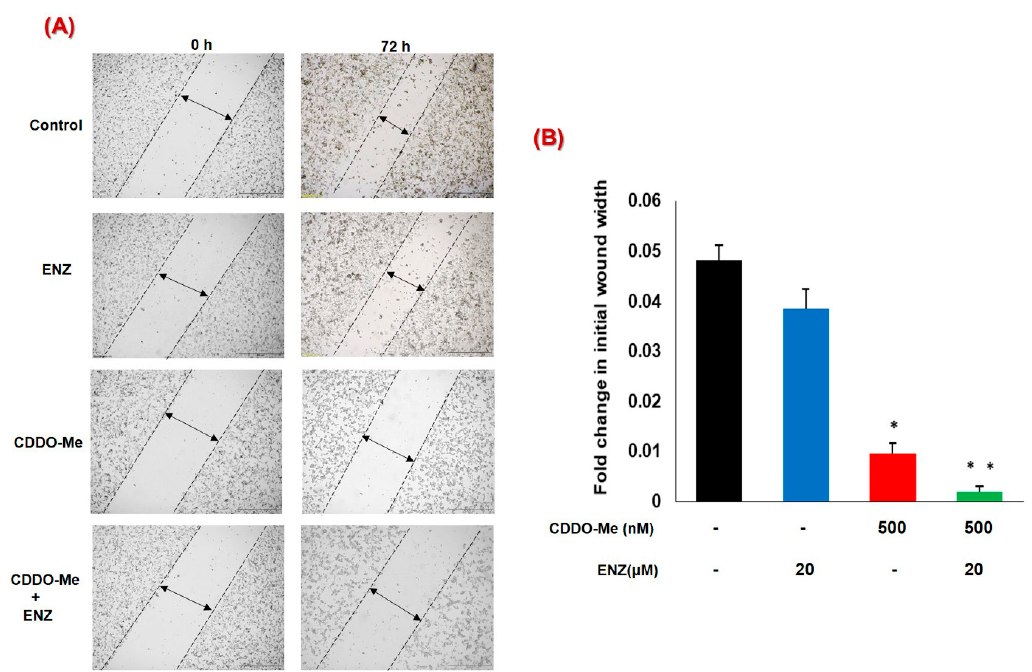
Figure 5. Effect of combination of CDDO-Me and ENZ on cell migration in 22Rv1 cells. Quantification of cell migration was examined by wound-healing assay. ( A ) A representative light microscope image of the wound at the 0 and 72 h time-points is shown in 22Rv1 cells. Images show wound closure in untreated (control) cells, and in cultures that were exposed to either CDDO-Me (500 nM), ENZ (20 µM), or CDDO-Me and ENZ combination. ( B ) Fold change in wound width is expressed as the mean ± SEM of two independent experiments, and significant differences between groups are shown as p -values (* p < 0.05; ** p < 0.005).